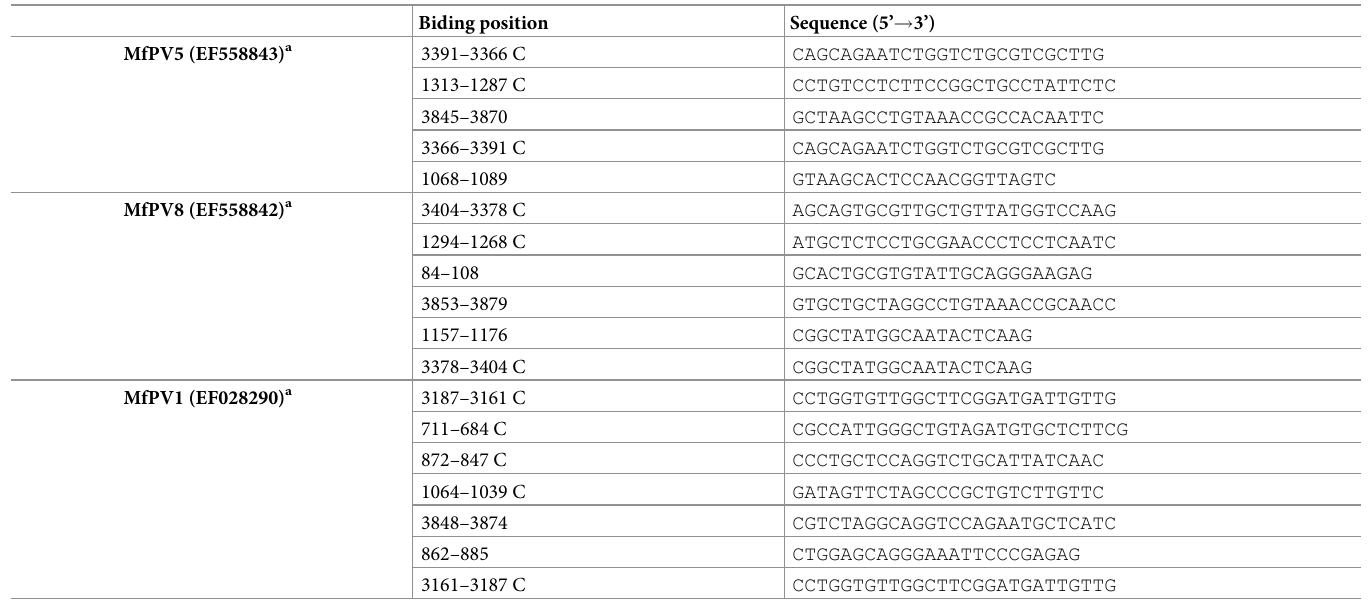
Table 1. Sequences of primers used for RACE analyses and